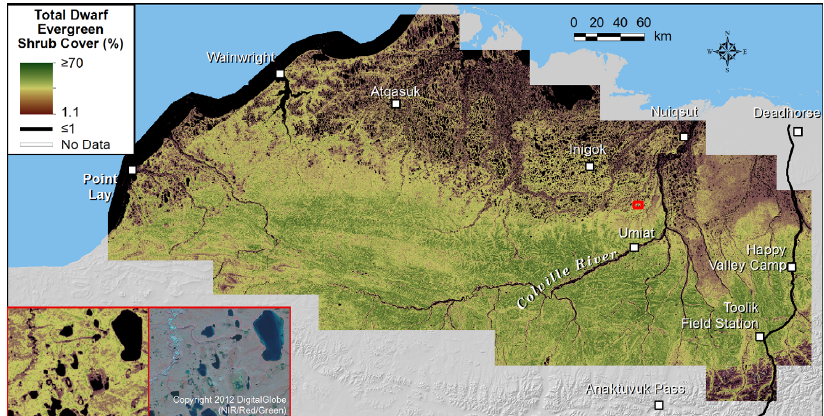
Figure 7. Map of dwarf evergreen shrub cover based on the random forest model with 78 predictors,